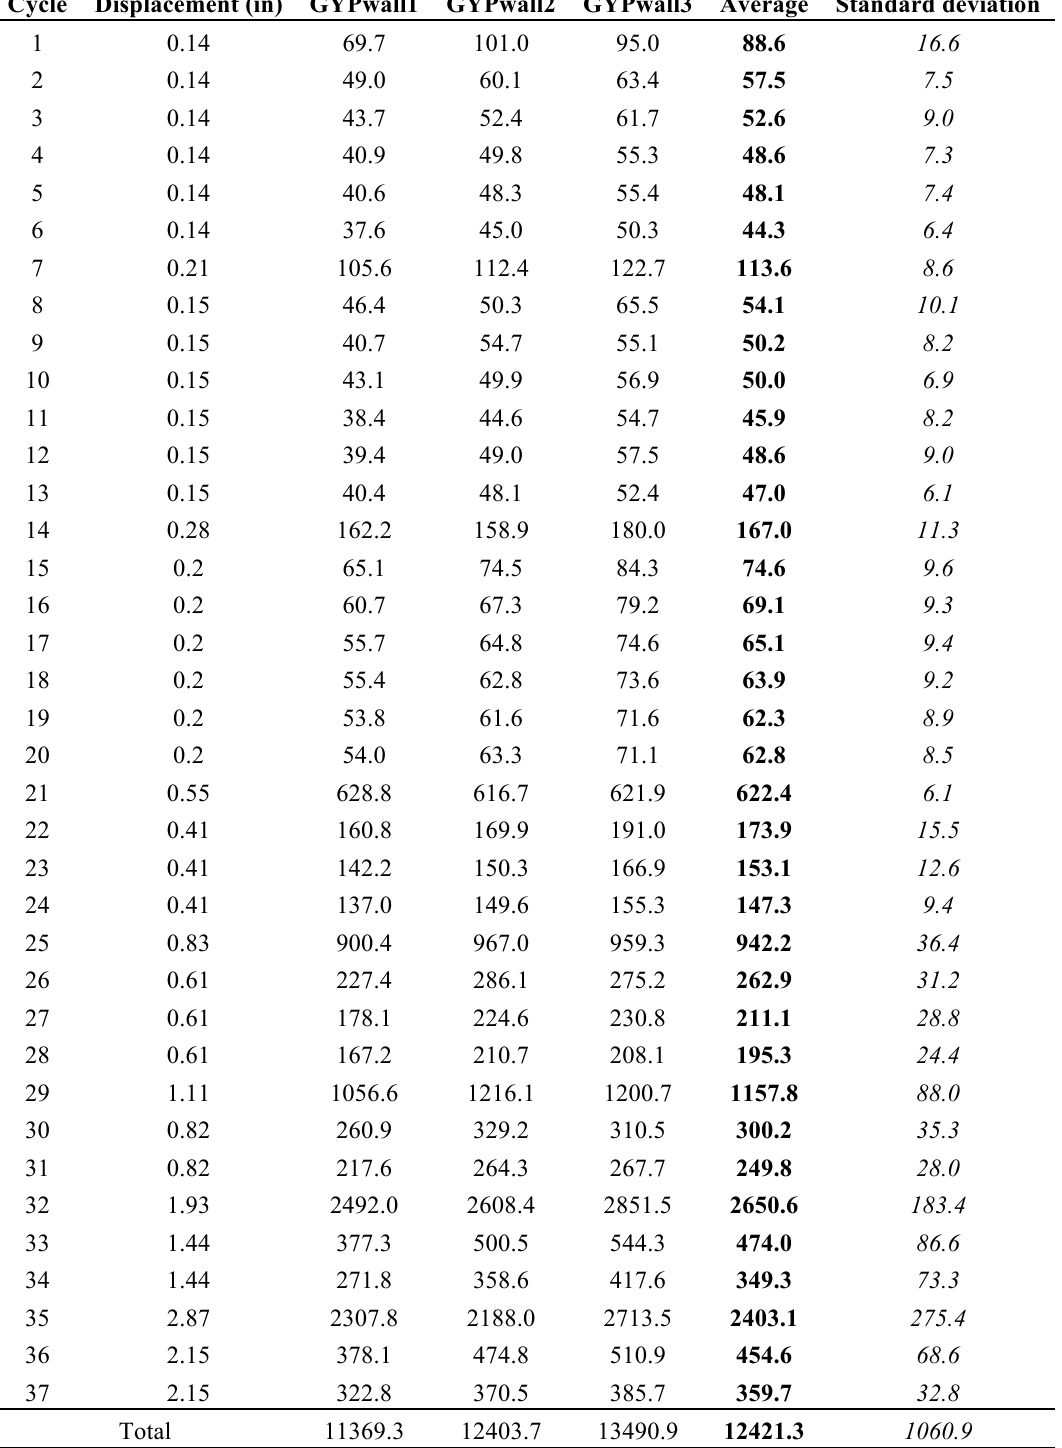
Table 2. Energy Dissipation (lb-in) of